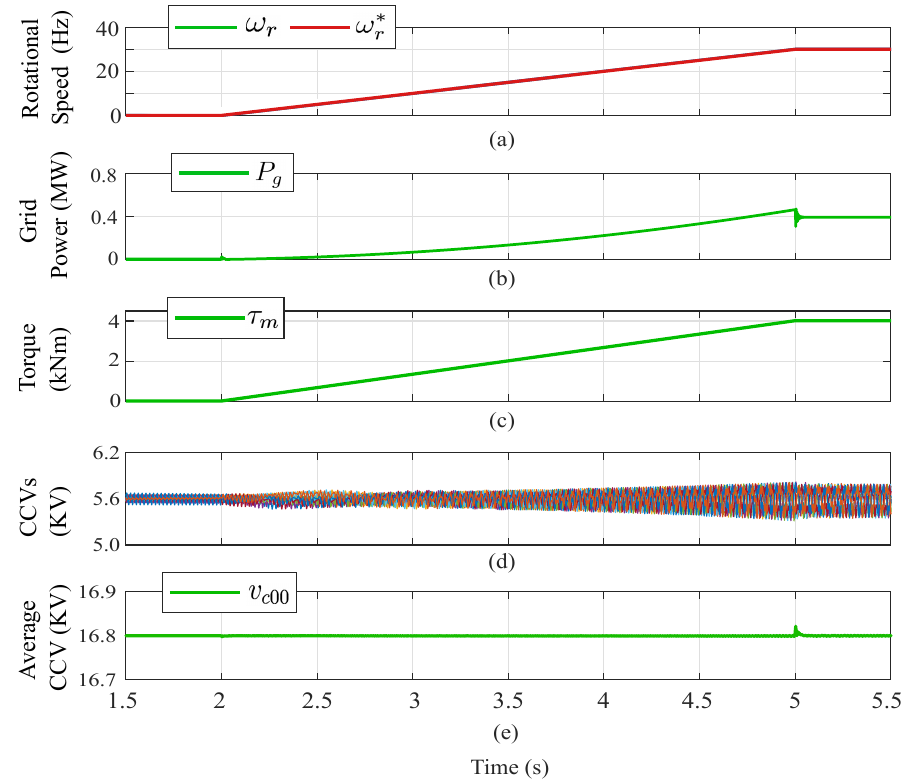
Figure 14. Results for variable-speed operation at lineal load. ( a ) Rotational speed ω r . ( b ) Input port power P in . ( c ) Mechanical torque τ m . ( d ) CCVs. ( e ) Average CCV. Adapted from